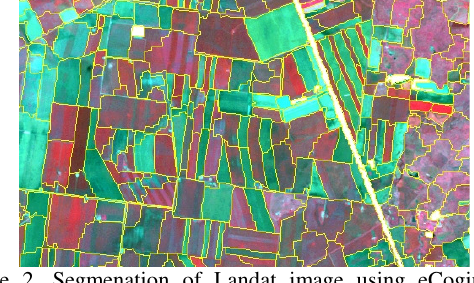
Figure 1. Location map of study area. Green areas indicate cropping regions for summer 2010.